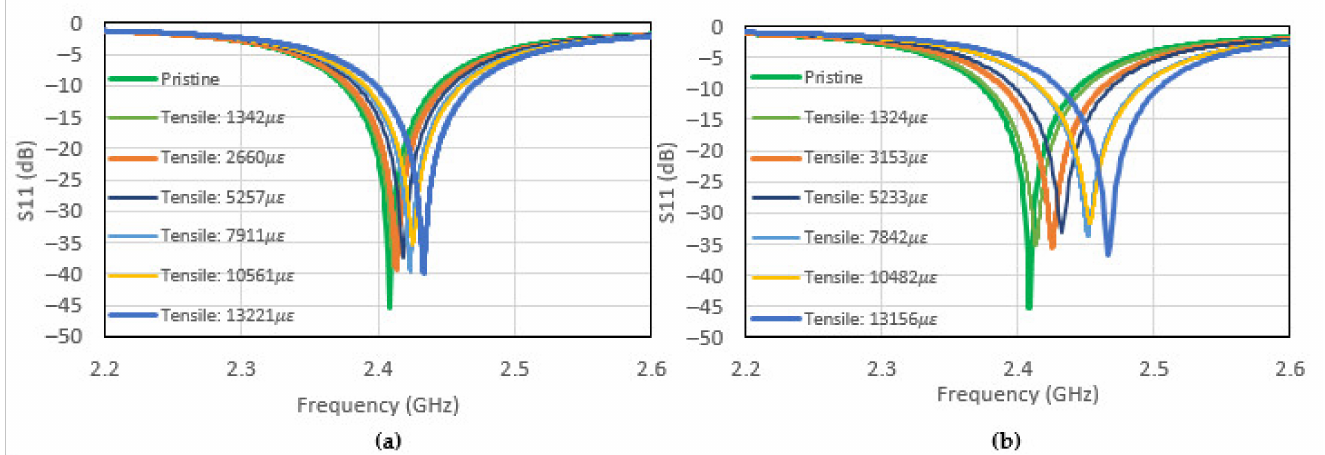
Figure 17. ( a ) CLAS’s S11 for the antenna with 5 mm disbond undergoing tensile loading at various levels and ( b ) CLAS’s S11 for the antenna with 10 mm disbond undergoing tensile loading at various levels. The changes in the resonant frequency for each disbond case are plotted in Figure